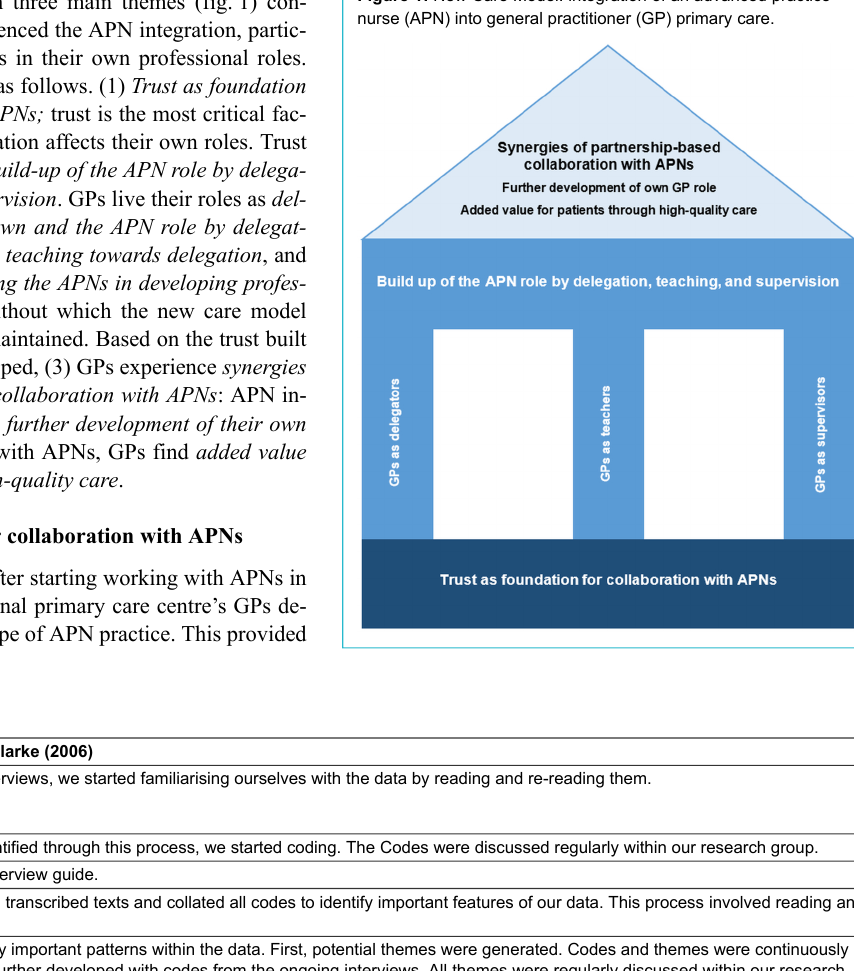
Figure 1: New Care Model: integration of an advanced practice nurse (APN) into general practitioner (GP) primary care.